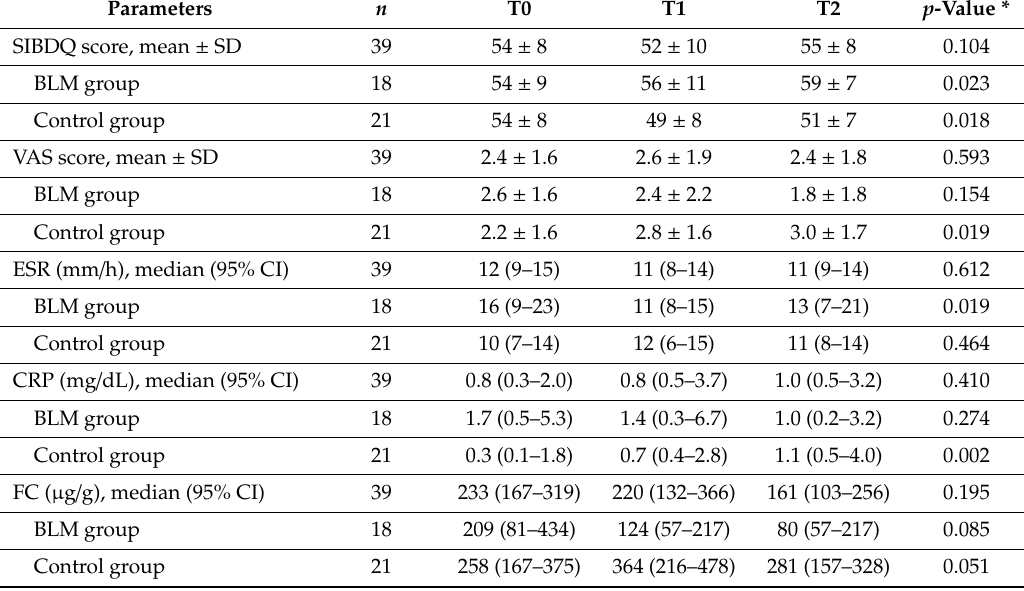
Table 2. Quality of life, abdominal pain, and inflammatory markers from T0 to T2 in the overall population of patients with UC and according to the BLM add-on therapy.